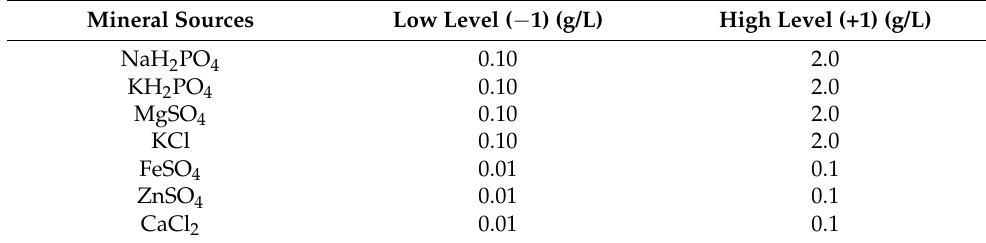
Table 3. The low and high levels of mineral salts used in the PB